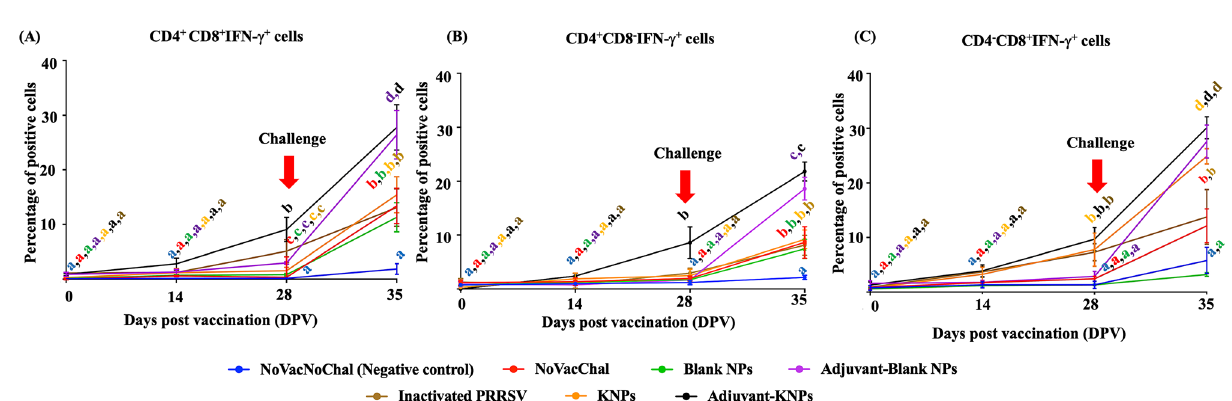
Figure 4. PRRSV-specific lymphocyte populations producing IFN-γ following vaccination. The IFN-γ- producing lymphocyte populations were identified by flow cytometry using cell surfaces and intracellular IFN-γ staining including ( A ) CD4 + CD8 + IFN-γ + cells, ( B ) CD4 + CD8 − IFN-γ + cells and (C) CD4 - CD8 + IFN-γ + cells. The data represents the mean ± SEM. The difference of lowercase letters exhibited significant differences between groups ( p <